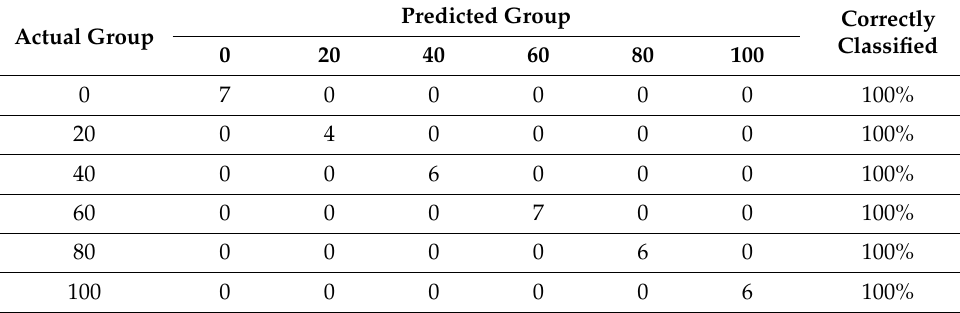
Table 7. Correctly classified cases in the validation